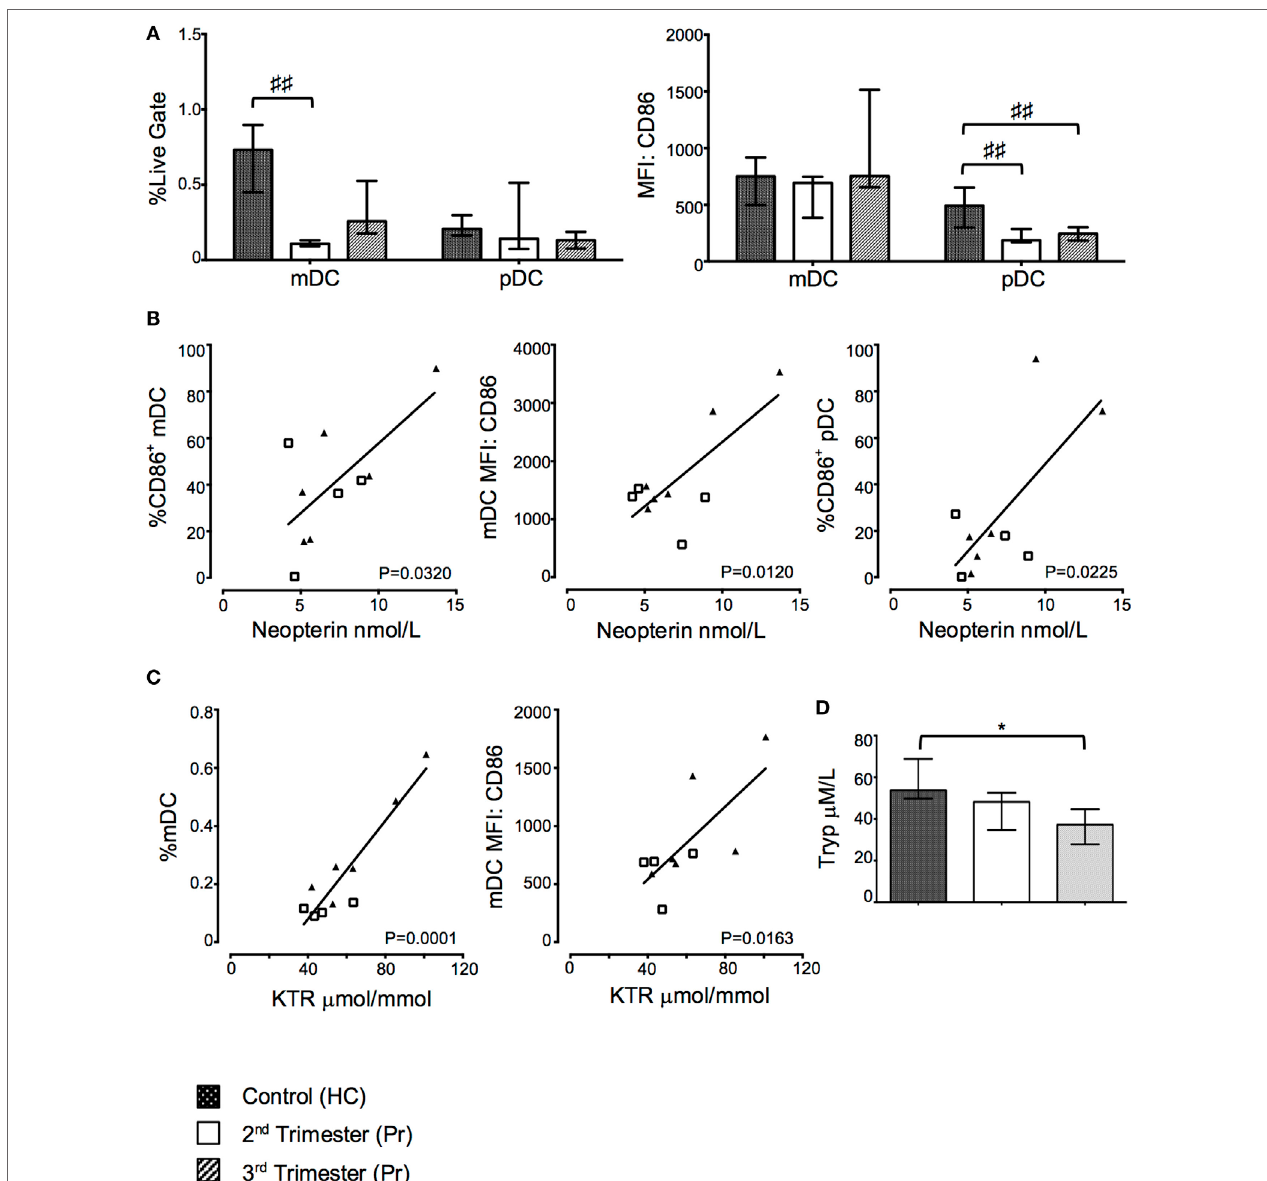
FigUre 5 | Proportions of myeloid dendritic cell (mDC) and costimulatory CD86 expression on plasmacytoid DC (pDC) were reduced in pregnancy but positively correlated with indoleamine 2,3-dioxygenase (IDO) activity. (a) Proportions of mDC and pDC and their respective expression of CD86 in pregnancy and compared to controls. (B) Correlation between CD86 expression on DCs and plasma neopterin concentration. (c) Correlation between mDC proportions, CD86 expression, and plasma kynurenine/tryptophan ratio (KTR). (D) Plasma tryptophan, kyurenine concentration, and KTR ( μ mol/mmol) during pregnancy. Columns indicate median and error bars interquartile range. ♯♯ p < 0.01 (Kruskal–Wallis one way analysis of variance and Dunn’s test for multiple comparisons), * p < 0.05 (Mann–Whitney U ). Abbreviations: HC, healthy control; MFI, mean florescence intensity; Pr,